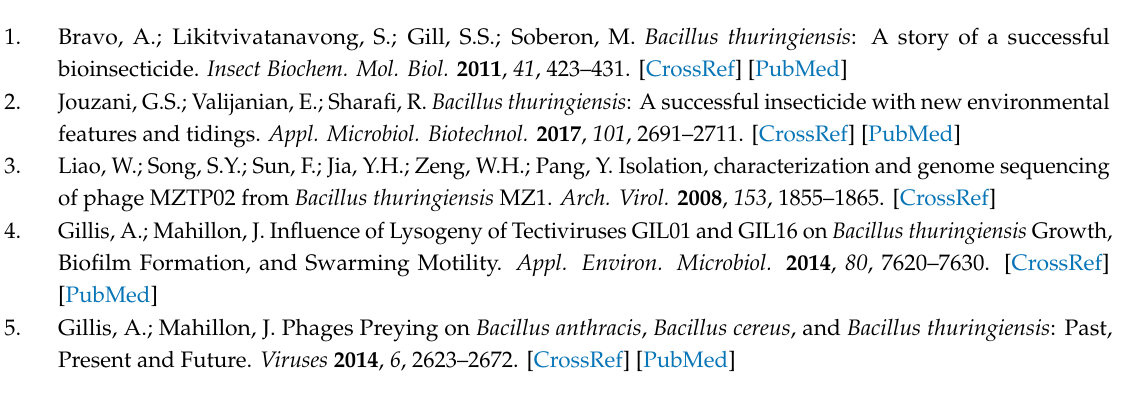
Table S1. Strains used for prophage prediction; Table S2. Prophages identified in Bt genomes; Table S3. Putative complete prophages identified in Bt genomes; Table S4. Bacillus phages used for pairwise comparison; Table S5. Host range of phages induced from Bt strains; Figure S1. Phylogenetic analysis of Bt prophages using the major capsid proteins; Figure S2. Phylogenetic analysis of Bt prophages using the terminase large subunits; Figure S3. Comparative genomic analysis of prophage from the Bt YBT-1518 strain; Figure S4. Comparative genomic analysis of prophage from the Bt Pasteur Institute Standard strain; Figure S5. Phylogenetic analysis of 41 Siphoviridae family phages; Figure S6. The genome comparison between induced phage phiHD73 and candidate prophages in resistant and susceptive Bt strains using Blastn; Figure S7. The amino acid sequences alignment of beta-lactamase in HD-521 prophage-1 with the beta-lactamase (PDB database accession number: 1yqs) from Streptomyces R61; Figure S8. The amino acid sequences alignment of beta-lactamase in HD-771 prophage-2 with the beta-lactamase (PDB database accession number: 1btl) from Escherichia coli ; Figure S9. The amino acid sequences alignment of glycopeptide resistance protein in Pasteur Institute Standard strain prophage-12 with the glycopeptide resistance protein (PDB database accession number: 2dln) from Escherichia coli